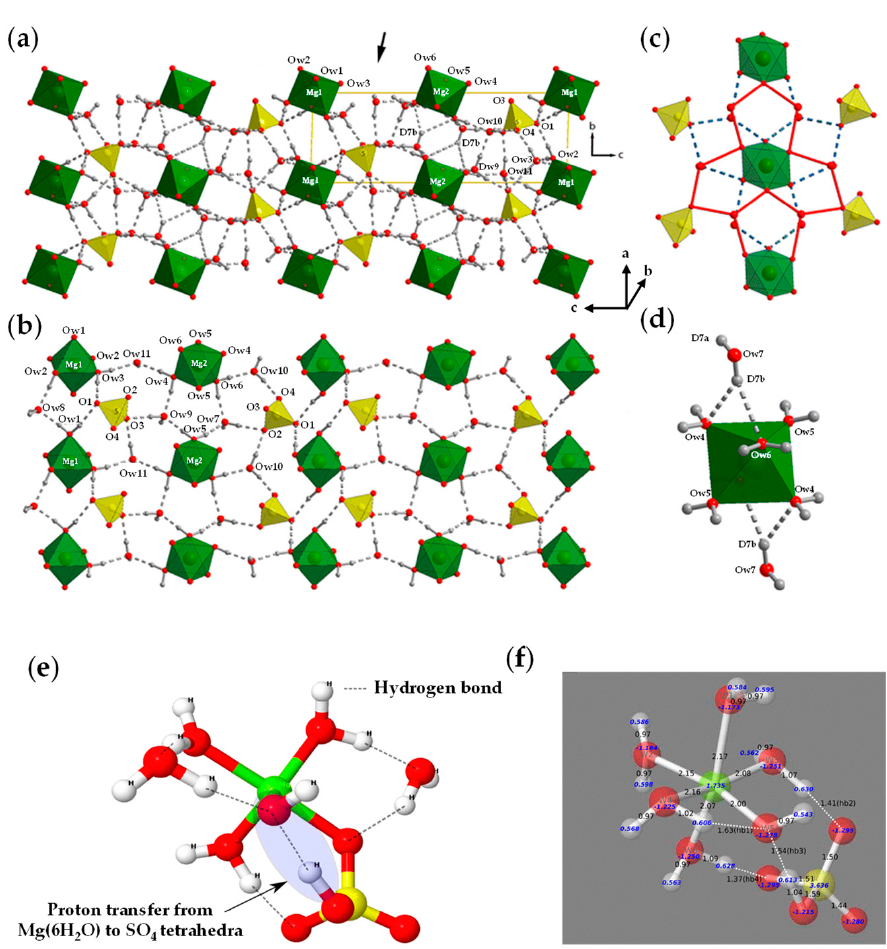
Figure 11. Crystal structure for MgSO 4 · 11H 2 O: ( a – d ) [87] and for MgSO 4 · 6H 2 O; ( e ) along with bond lengths for MgSO 4 · 6H 2 O ( f ) [90]: Reprinted with permission from Ref. [87]. Copyright © Springer- Chemical Society Verlag 2008 All rights reserved; with permission from Ref. [90]. Copyright © 2012 American Chemical Society All rights reserved.